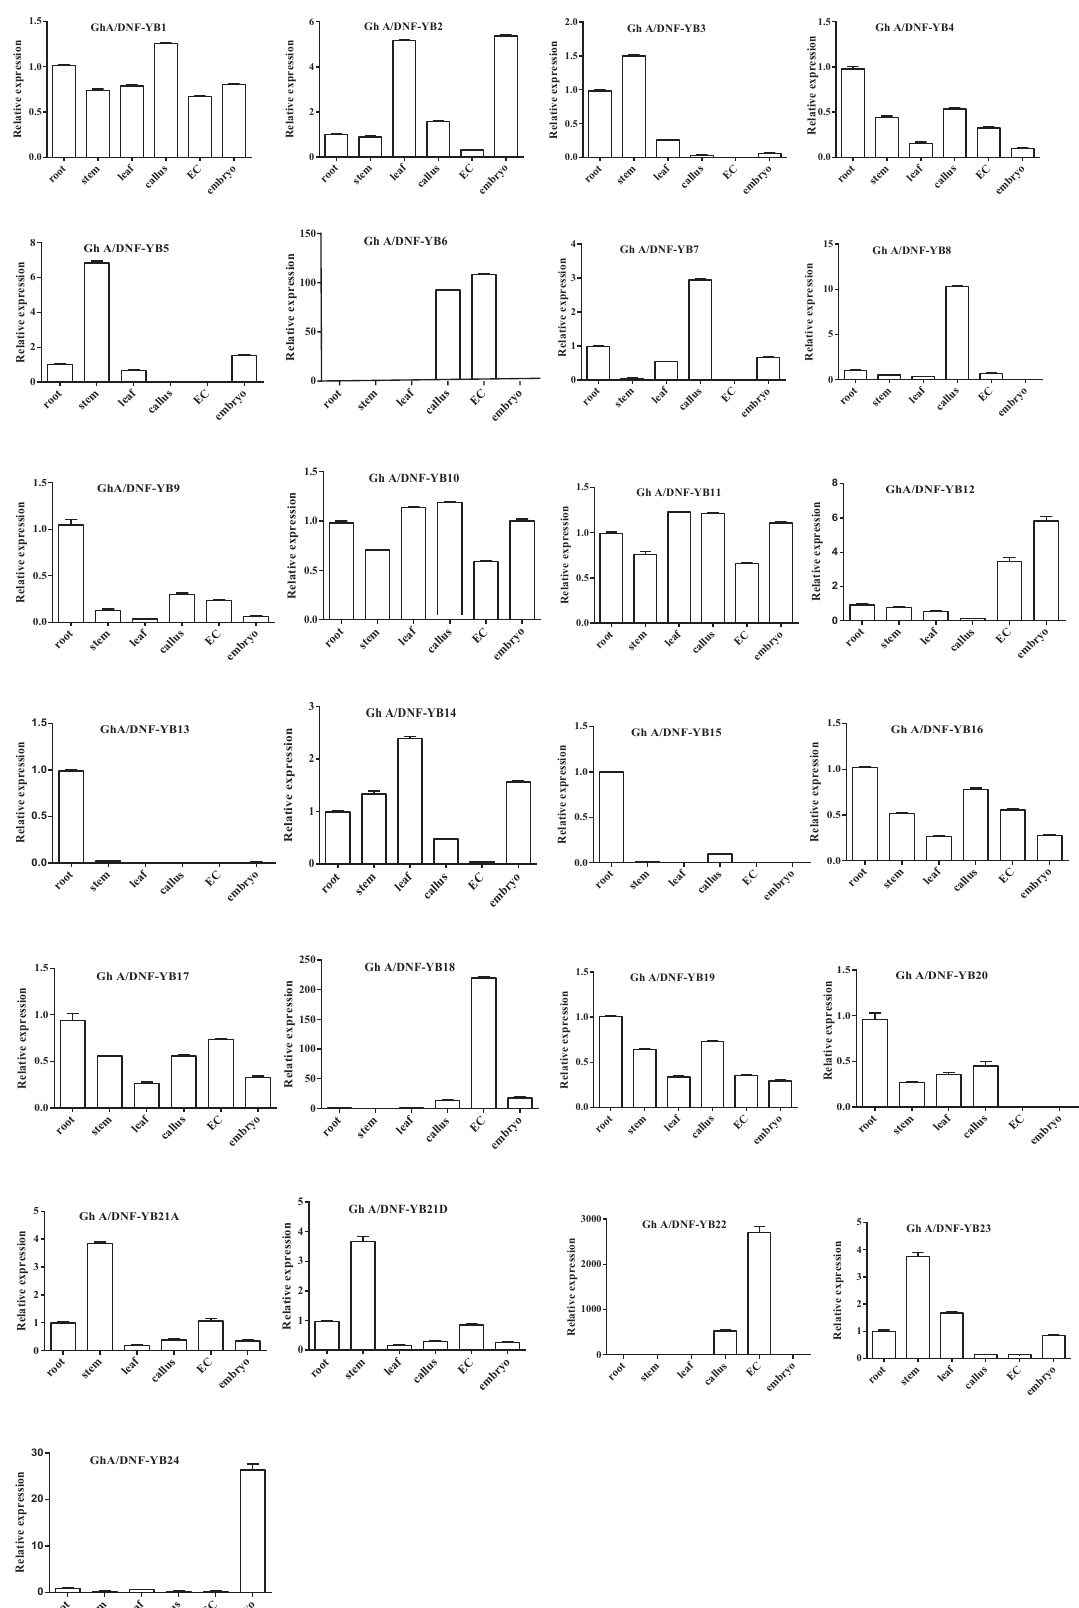
Figure 5. Expression levels of NF-YB genes in different tissues, as determined by qRT-PCR. Error bars represent the standard deviations of three independent